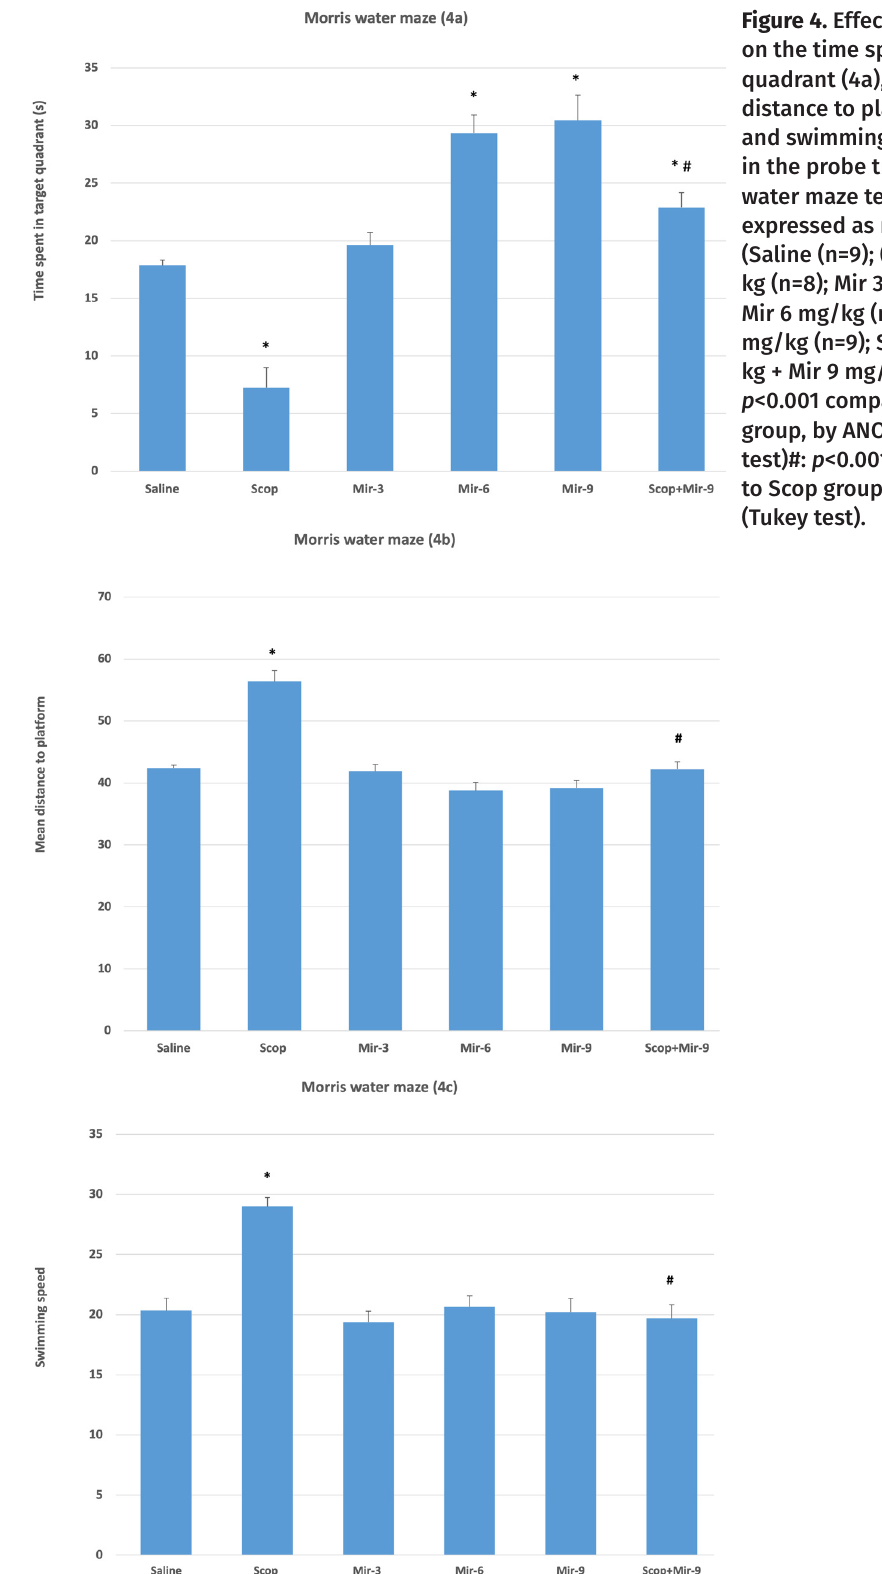
Figure 4. Effects of